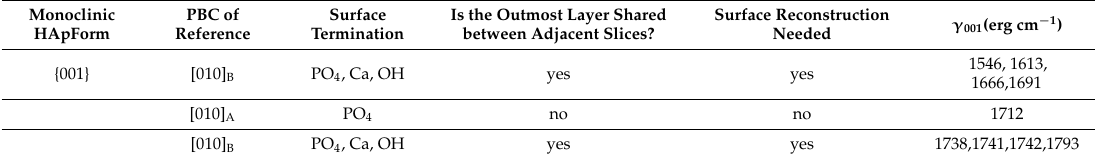
Table 3. Surface features and corresponding specific surface energy values related to the {001} form*. Monoclinic